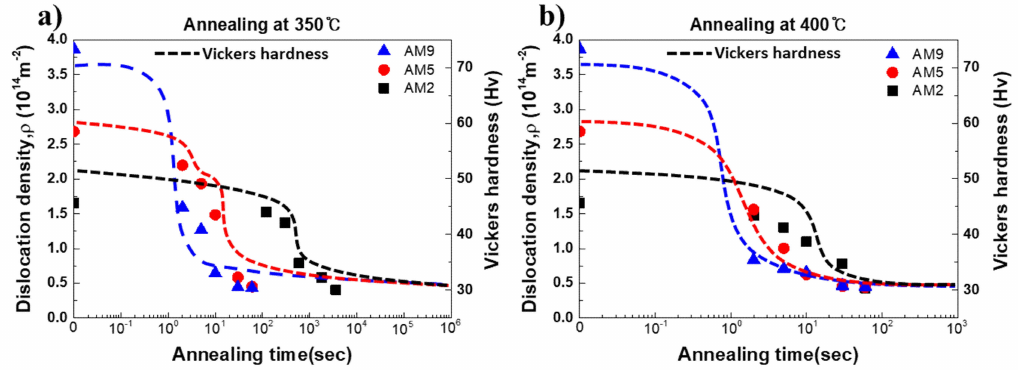
Figure 12. Change in the dislocation density as a function of annealing time at ( a ) 350 ◦ C and ( b ) 400 ◦ C in AM2, AM5, and AM9.